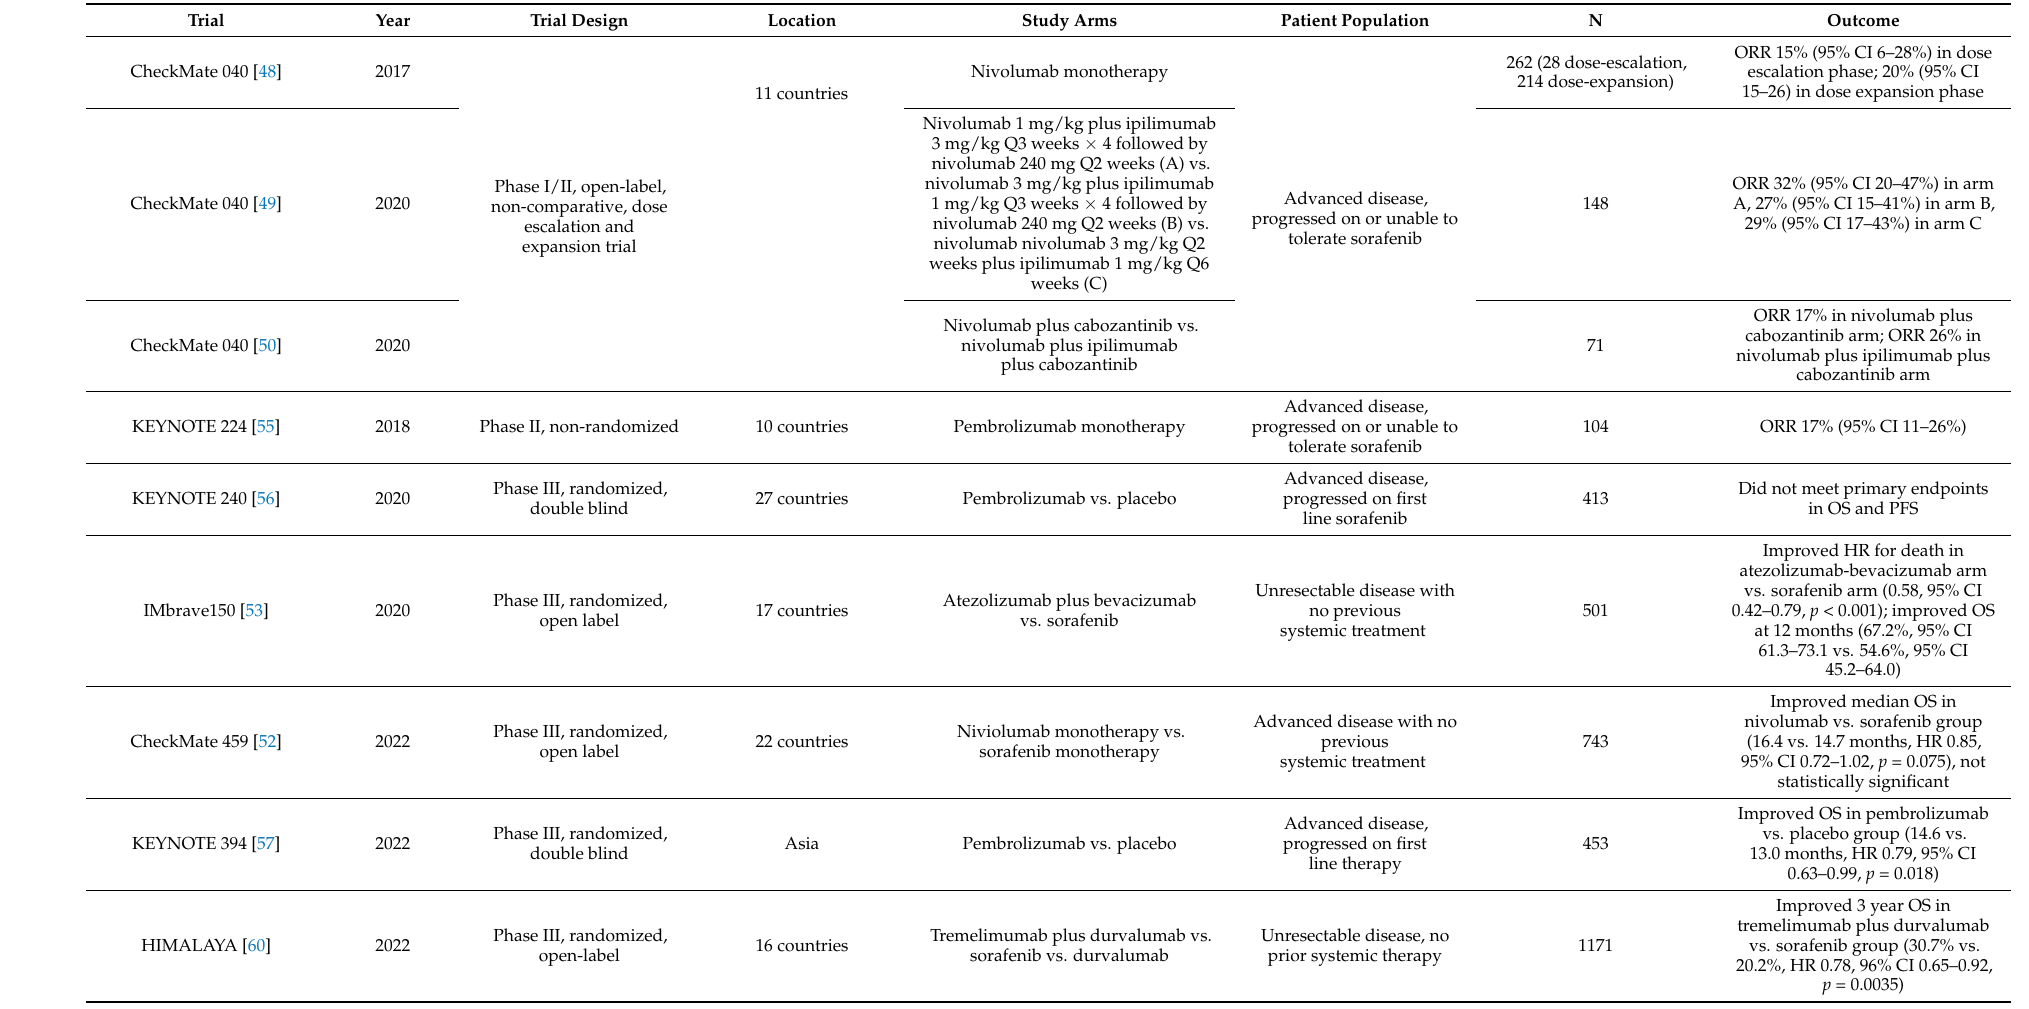
Table 3. Landmark trials of immunotherapy in hepatocellular